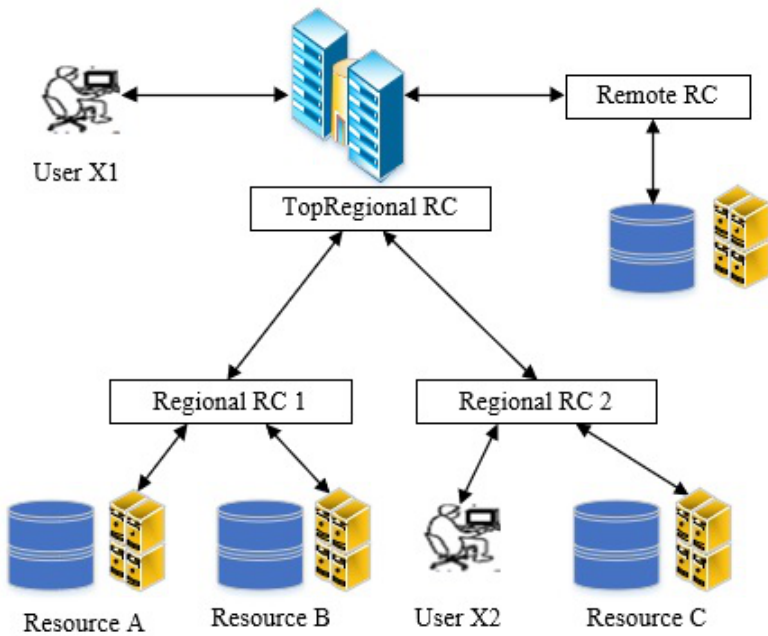
Figure 1. Communication process flow between Top, Regional and Remote